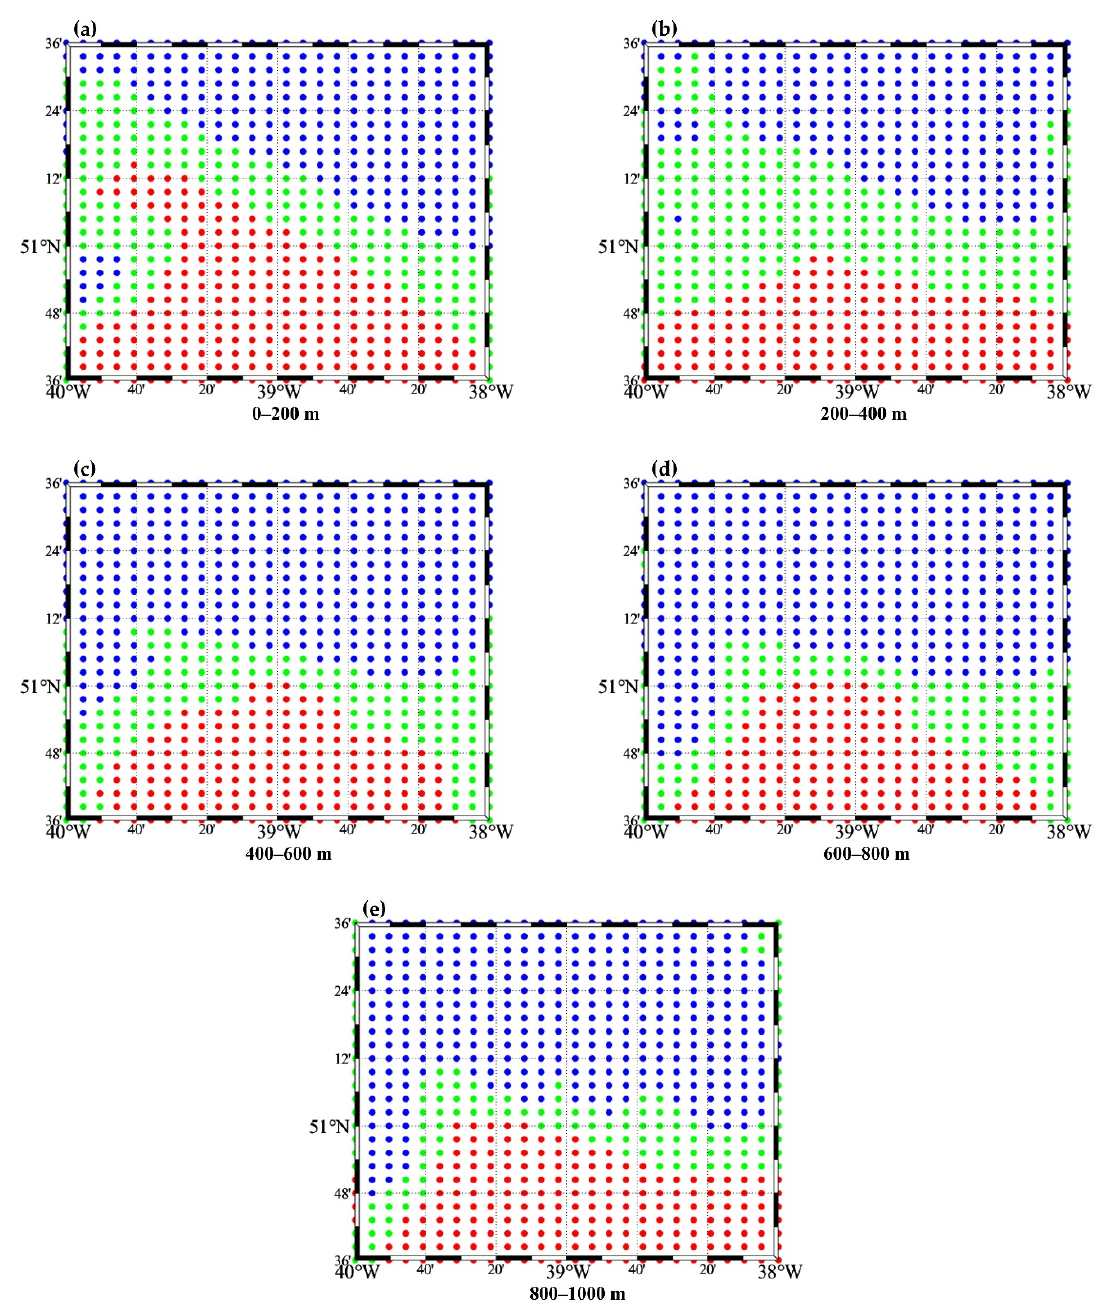
Figure 4. The results of clustering the sound speed profiles of the study sea area via K-means (the blue points represent the north water mass of the frontal zone, the red points represent the south water mass of the frontal zone, and the green points represent the frontal transition water mass): ( a ) 0–200 m; ( b ) 200–400 m; ( c ) 400–600 m; ( d ) 600–800 m; ( e ) 800–1000 m.